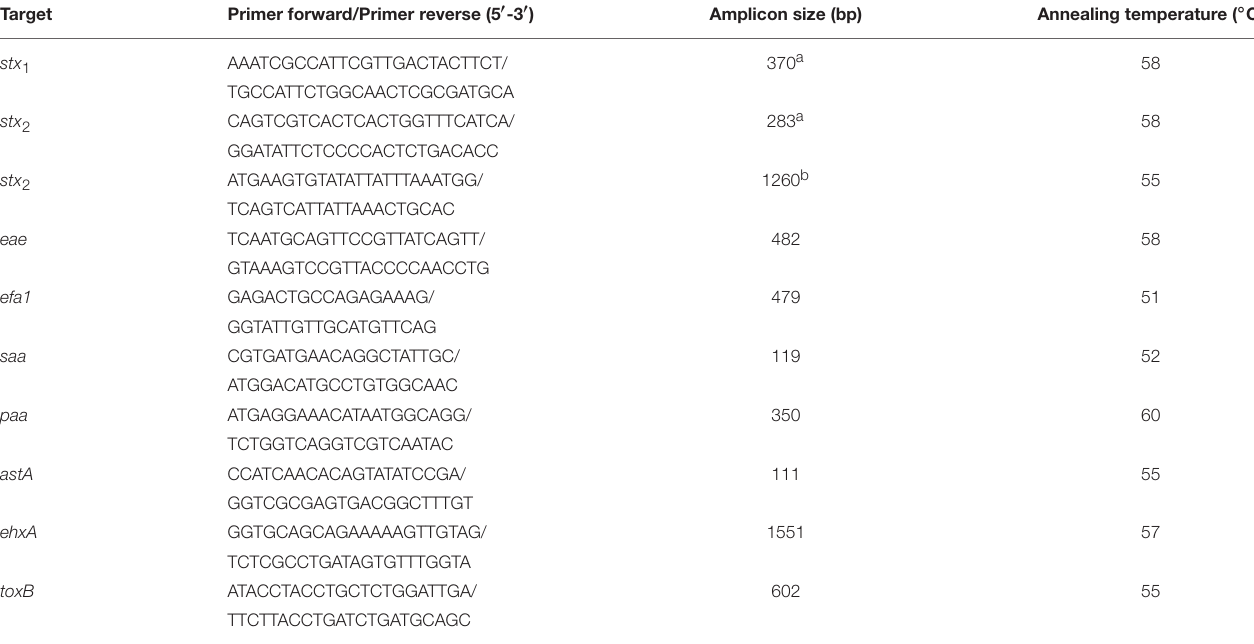
TABLE 2 | PCR primers used for the detection of STEC virulence or adherence genes (Bai et al., 2016).